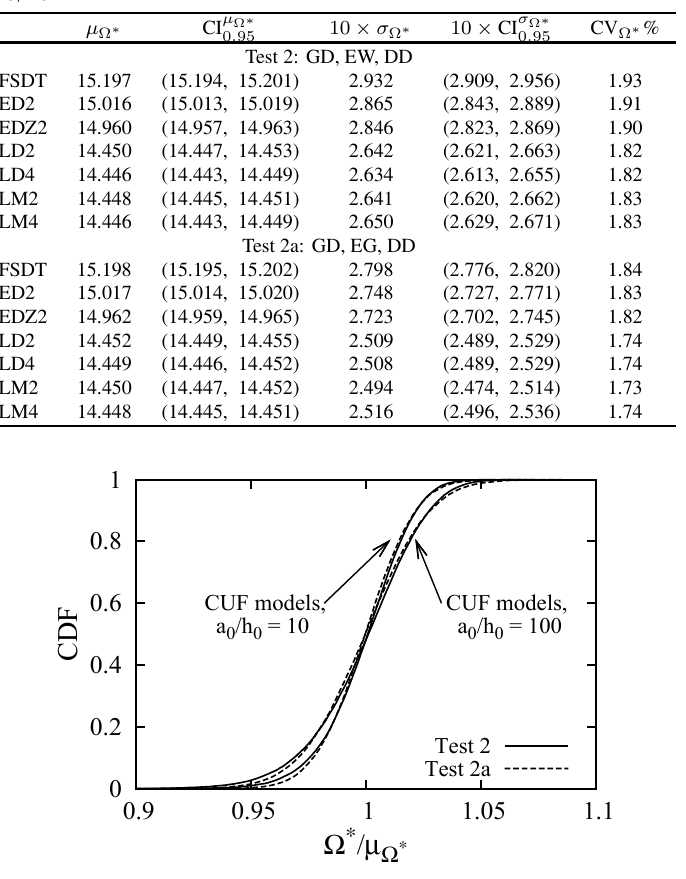
Fig. 8. Cumulative Distribution Function for the anti-symmetric laminate, fi rst material, a 0 /h 0 = 100 and a 0 /h 0 = 10, tests 2 and